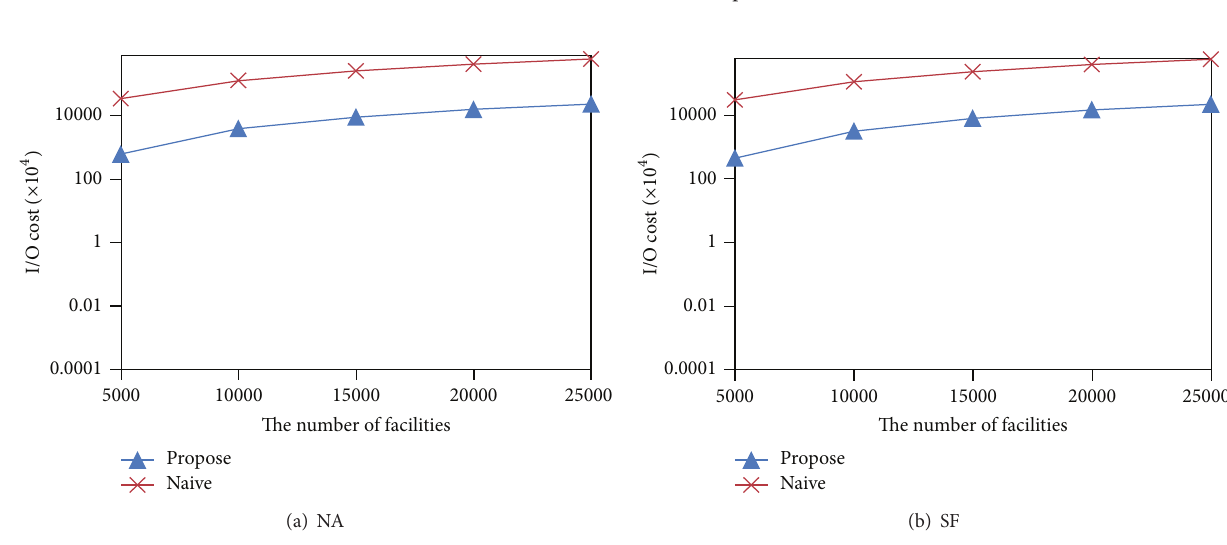
Figure 12: Two datasets used in experiments.